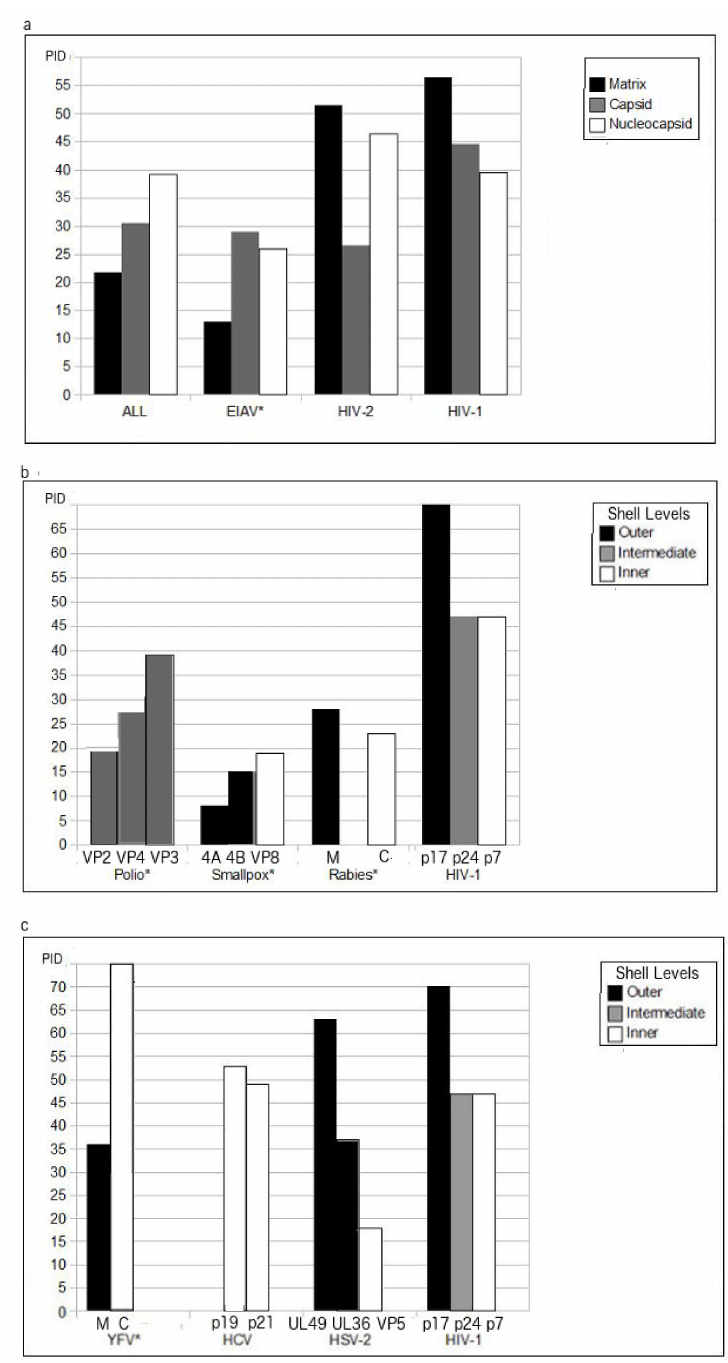
Figure 2. Comparison of PID of shell proteins of related. ( a ) Retroviruses: HIV vs. EIAV ( b ) HIV-1 vs. polio, smallpox and rabies viruses. ( c ) YFV vs. HCV, HSV and HIV-1. ( * ) denotes viruses for which e ff ective vaccines are available. For illustrative purposes, only the tegument proteins with the highest and lowest PIDs are shown. Figure 2a shows the mean PID, whereas, in ( b , c ), each PID represents maximal PID found for the specific protein. The reason for the use of both mean and maximal values is that the mean PID alone can be quite misleading for the readers, and sometimes maximal number paints a more accurate picture. “ALL” refers to the mean shell PIDs of viruses in general as seen in the current database of over 300 viruses and strains. YFV M (Matrix) and C (Capsid) PIDs are